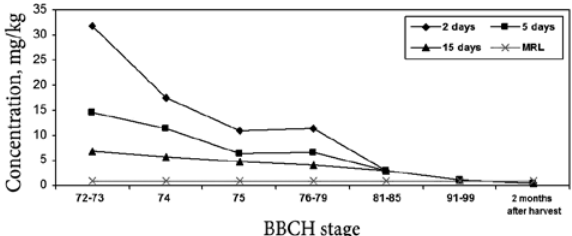
Fig. 6. Degradation of chlorothalonil in Jonathan apples